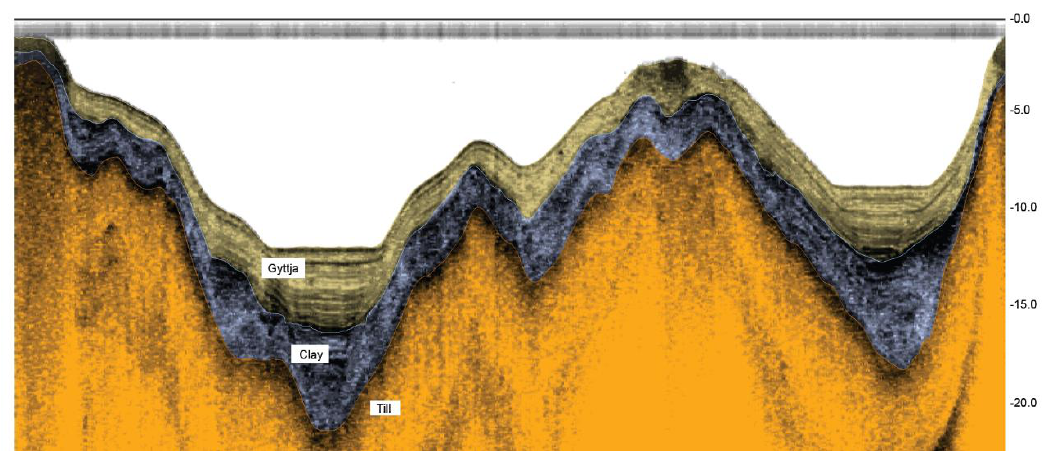
Figure 4. Example of an echo sounding profile and interpretation from Lake Halmejärvi (ID 1310 impacted).